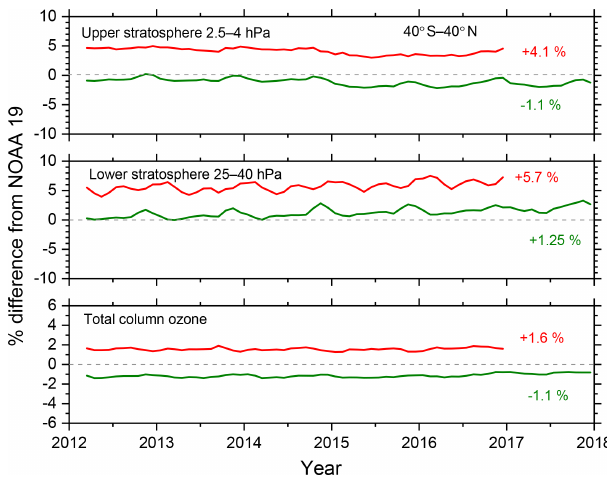
Figure 8. The NP ozone anomaly, the difference from NOAA 19 ozone, for midlatitudes and low latitudes is shown as a function of time for total column ozone, the lower stratosphere, and the upper stratosphere. Ozone from the version 1 processing (in red) and the version 2 processing (in green) is